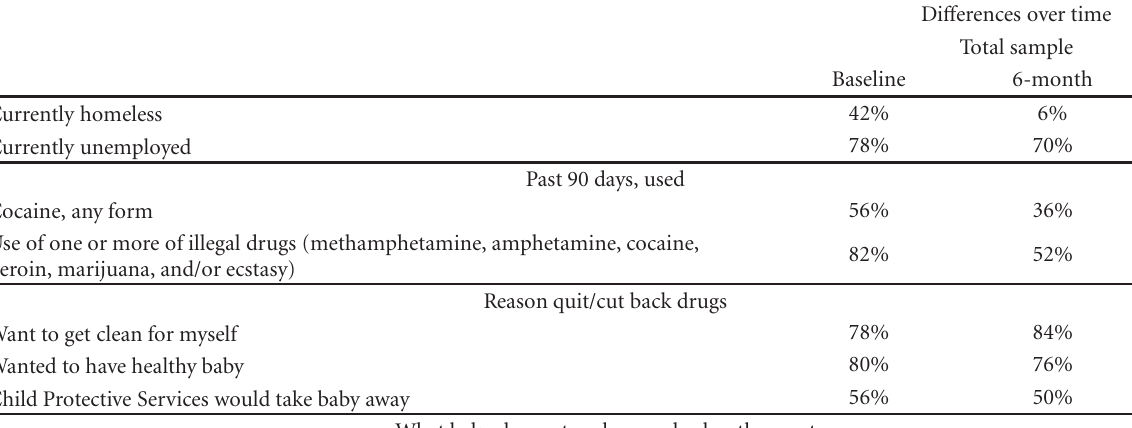
Table 2: Outcomes for the six-month reduced